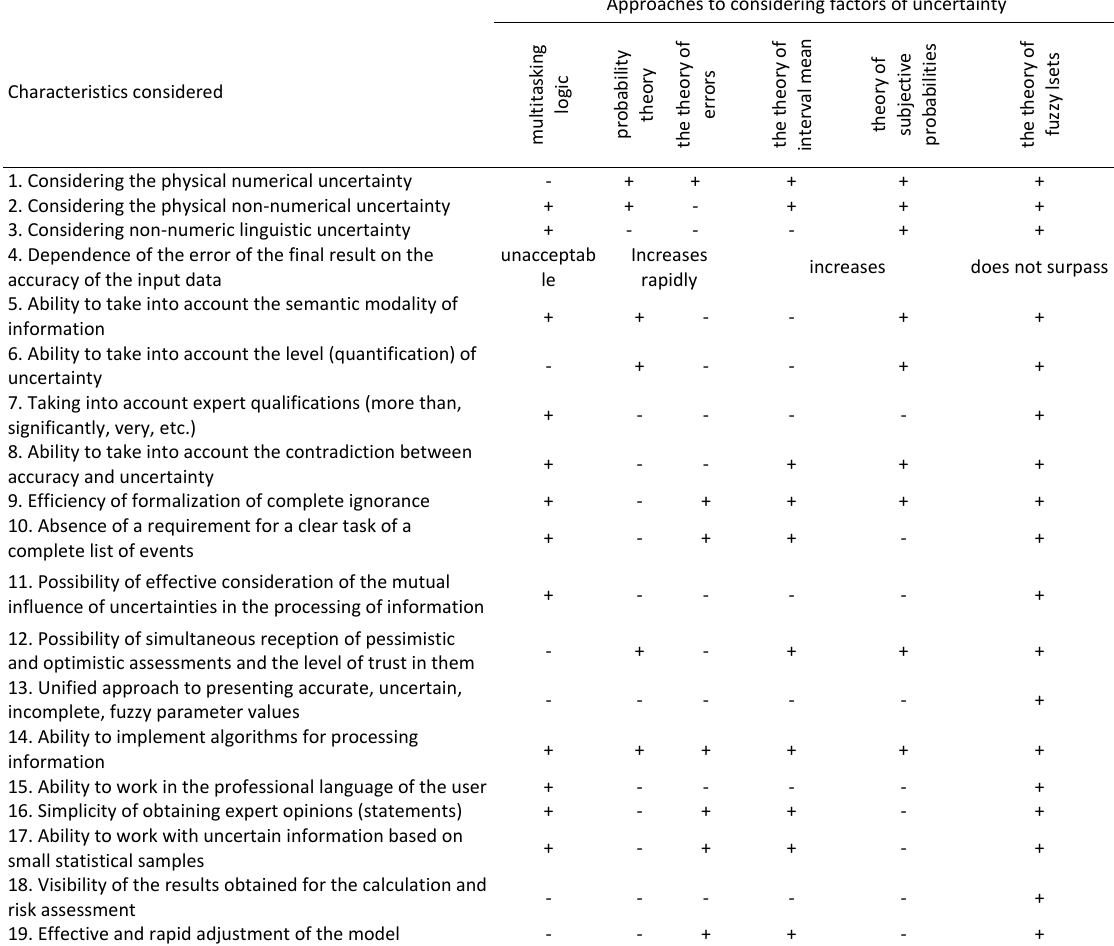
Table 1: Methodological analysis of the choice of mathematical apparatus for solving the study problem